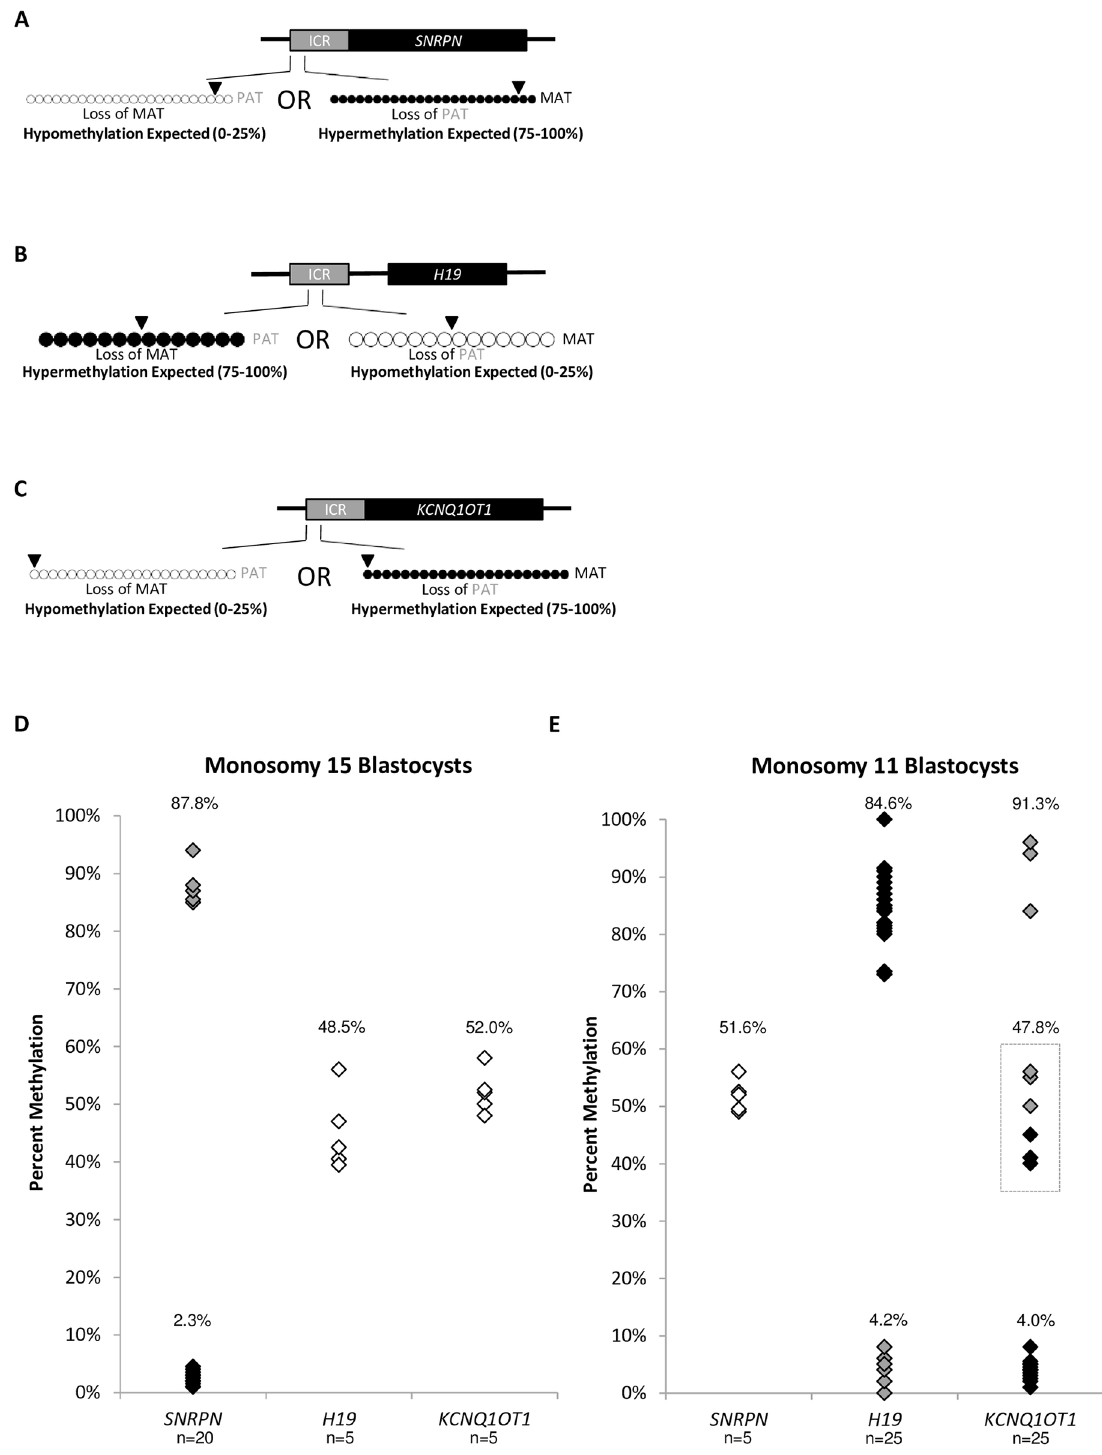
Fig 3. Imprinted DNA methylation profiles of monosomy blastocysts. Black dots represent methylated CpGs, white dots represent unmethylated CpGs. The SNP location is indicated by an arrowhead. “ MAT ” represents the maternal oocyte- contributed allele; “ PAT ” represents the paternal sperm-contributed allele. A) Diagram of the SNRPN ICR amplified region analyzed in monosomy 15 blastocysts. Hypomethylation (0 – 25%) is expected with the presence of only the PAT allele. Hypermethylation (75 – 100%) is expected with the presence of only the MAT allele. B) Diagram of the H19 ICR amplified